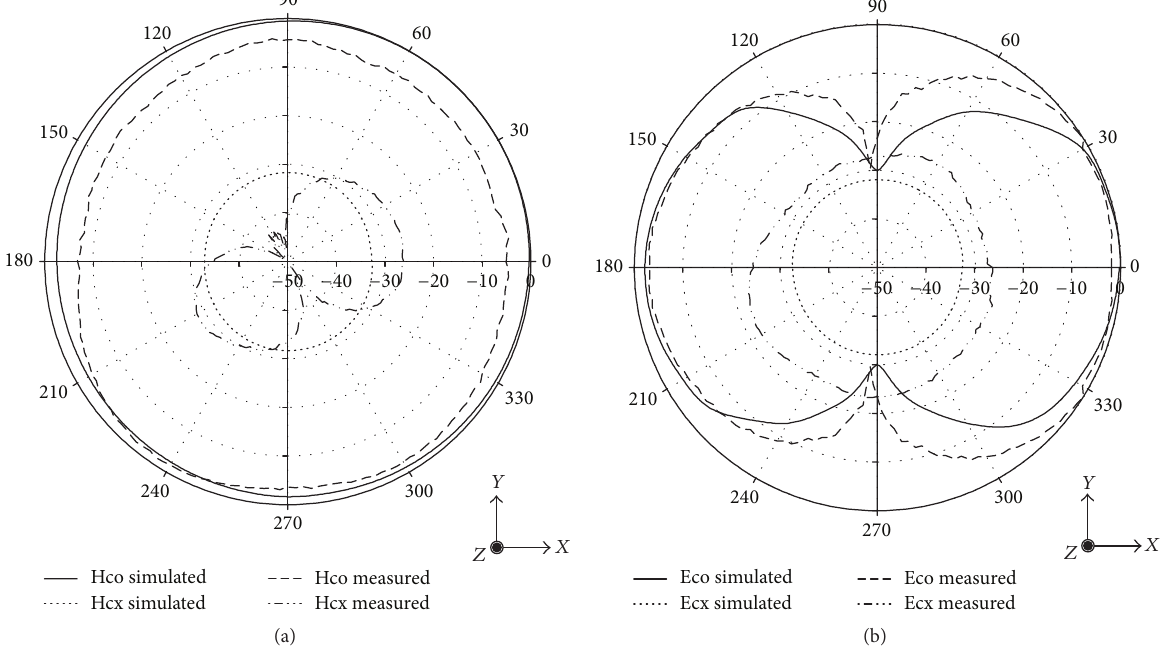
Figure 11: Measured and simulated radiation patterns of the antenna at the second band (5.8 GHz). (a) H-plane. (b) E-plane.